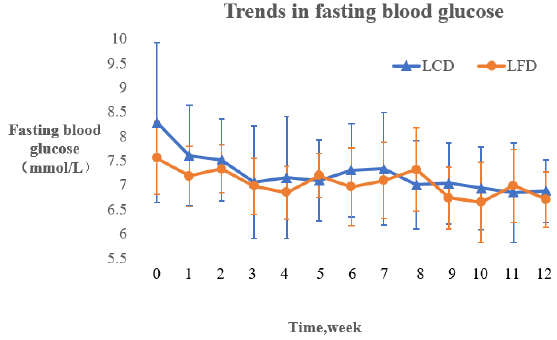
Figure 4. The changing trends of the FBG in the LCD and LFD Groups. FBG: fasting blood glucoses